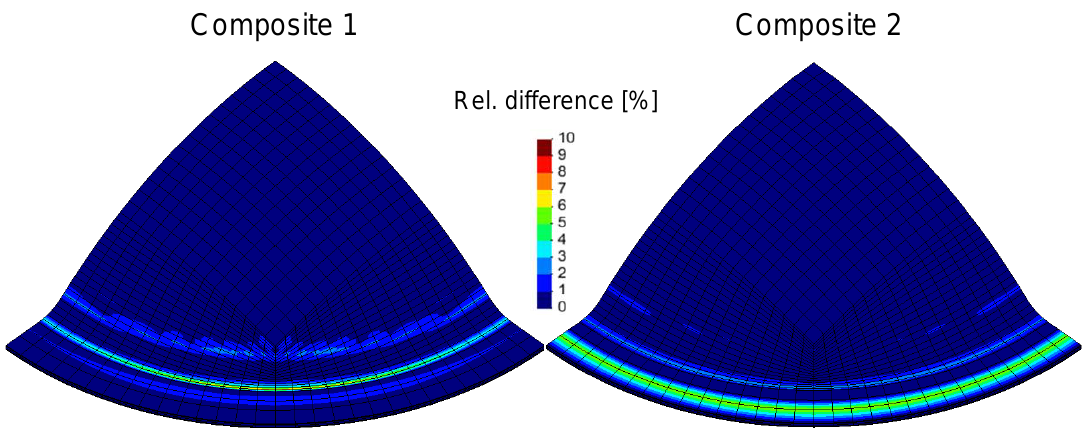
Figure 9. Distributions of relative difference (%) between the equivalent stress obtained for the numerical simulation of the equivalent material and the equivalent stress calculated from the rule of mixture (Equation (3)), using the numerical results of the composite.